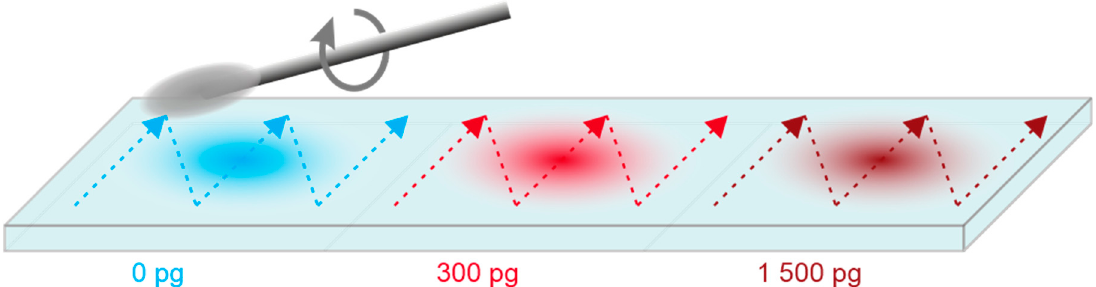
Figure 4. Polymer slide with individual sample squares containing 0, 300, and 1500 pg cocaine. Performed swiping pattern with the cotton swab is shown (colored arrows).